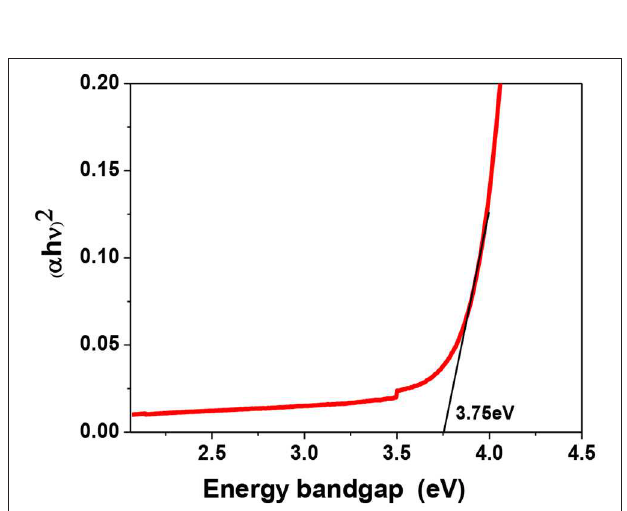
FIGURE 5 | Tauc plot of α -MoO 3 nanoparticles calcined at 500 ◦